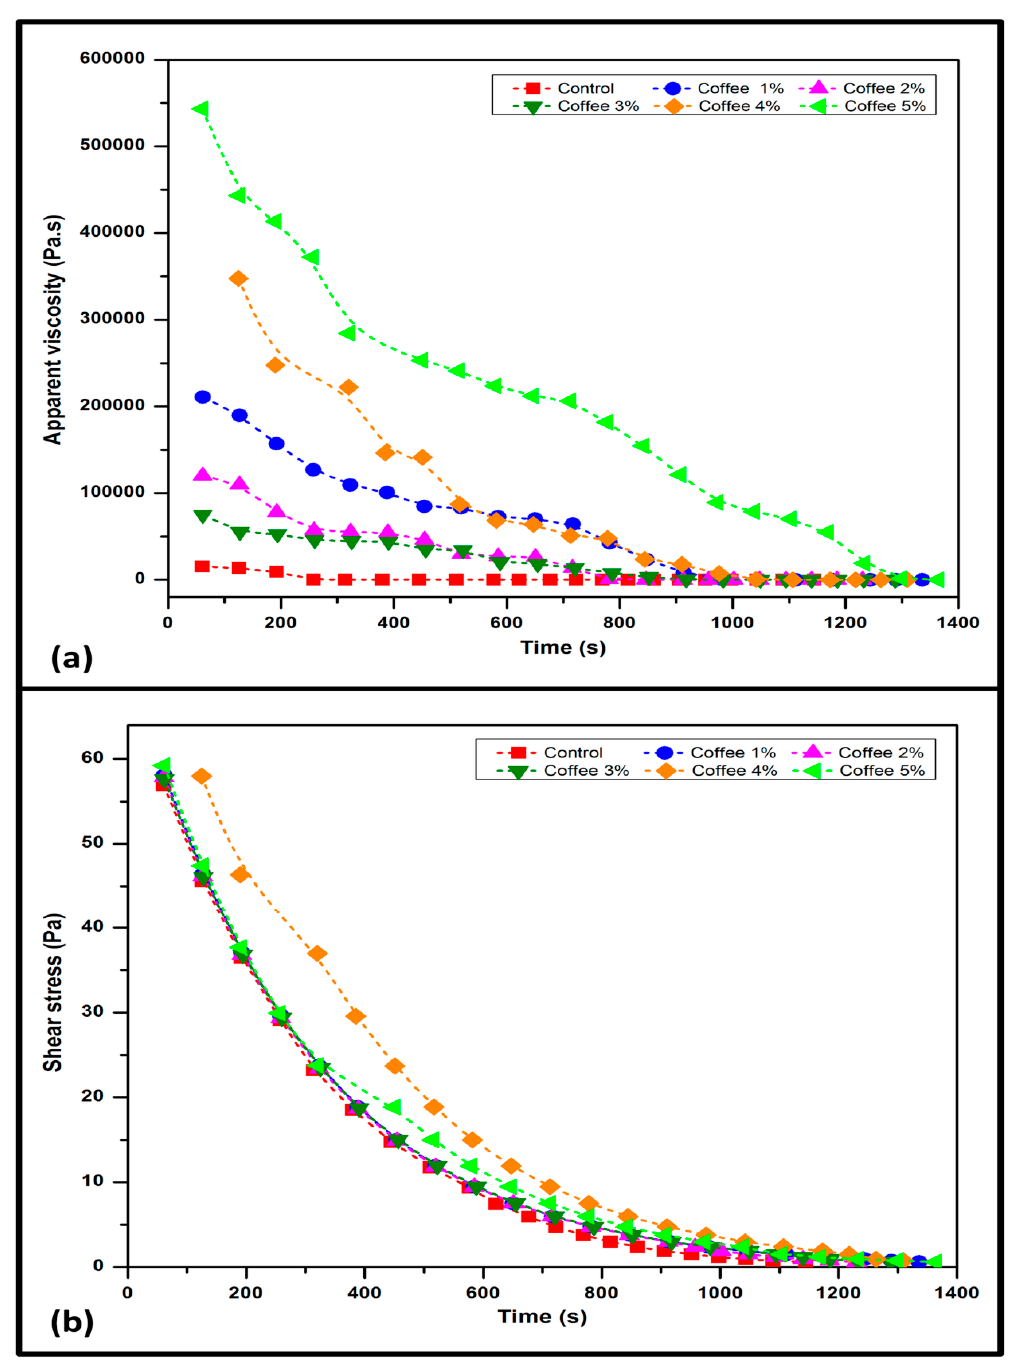
Figure 2. ( a ) The relation between time of shearing and apparent viscosity for seaweed/coffee film solution. ( b ) Effect of shear stress on time of seaweed/coffee film solution at different coffee load- ings.